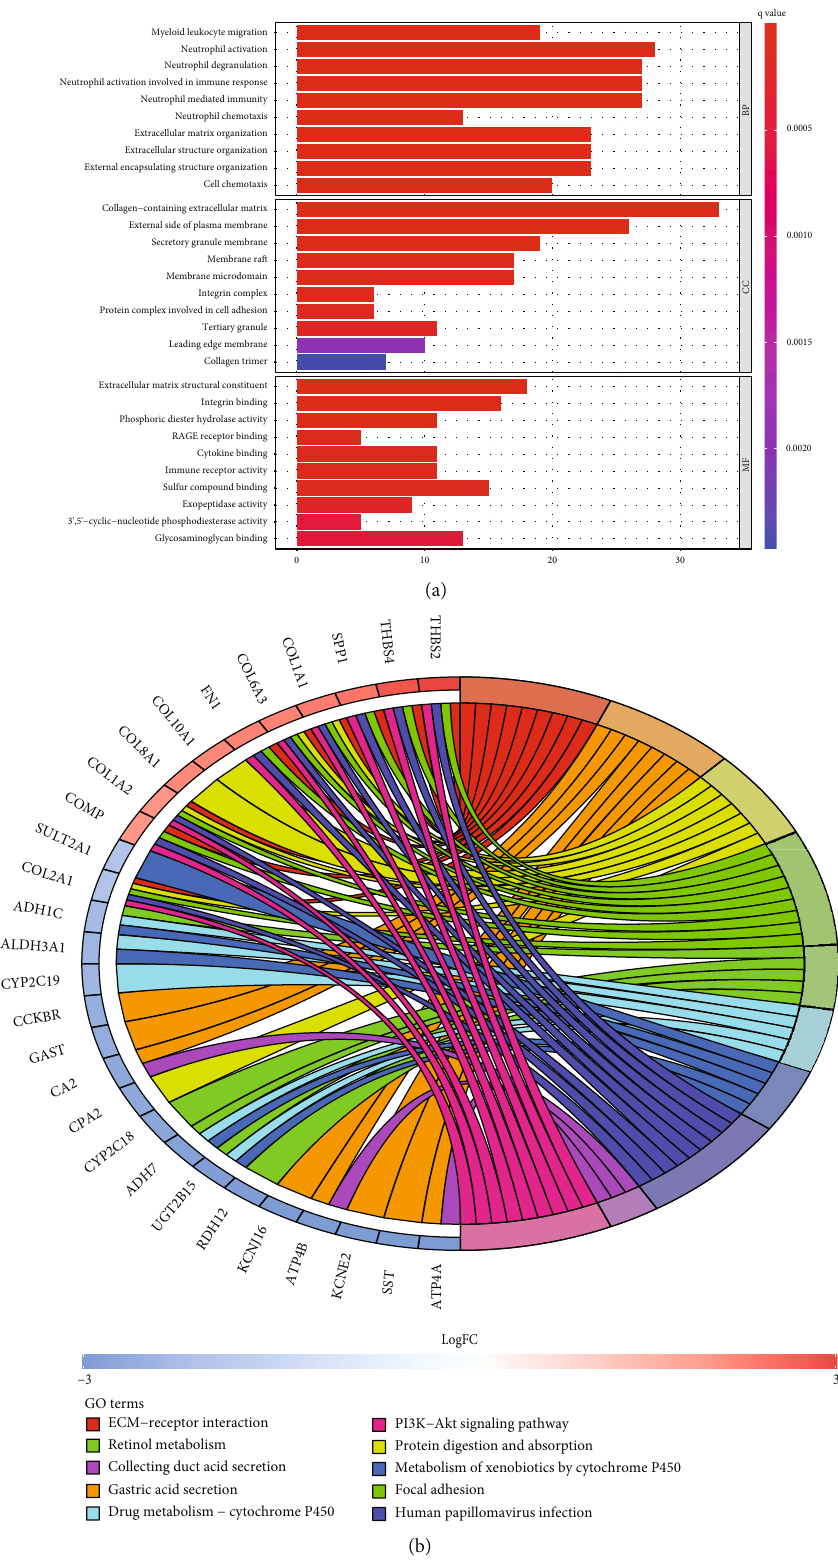
Figure 4: Functional enrichment analyses of DEGs. (a) Gene Ontology (GO) enrichment analyses of DEGs. The x -axis shows the number of genes enriched on the terms, and the y -axis shows the pathway terms. The q -value of each term is colored according to the legend. BP: biological process; CC: cellular component; MF: molecular function; (b) Kyoto Encyclopedia of Genes and Genomes (KEGG) enrichment analyses of DEGs. The q value of each term is colored according to the legend. The di ff erent colors represent di ff erent pathway